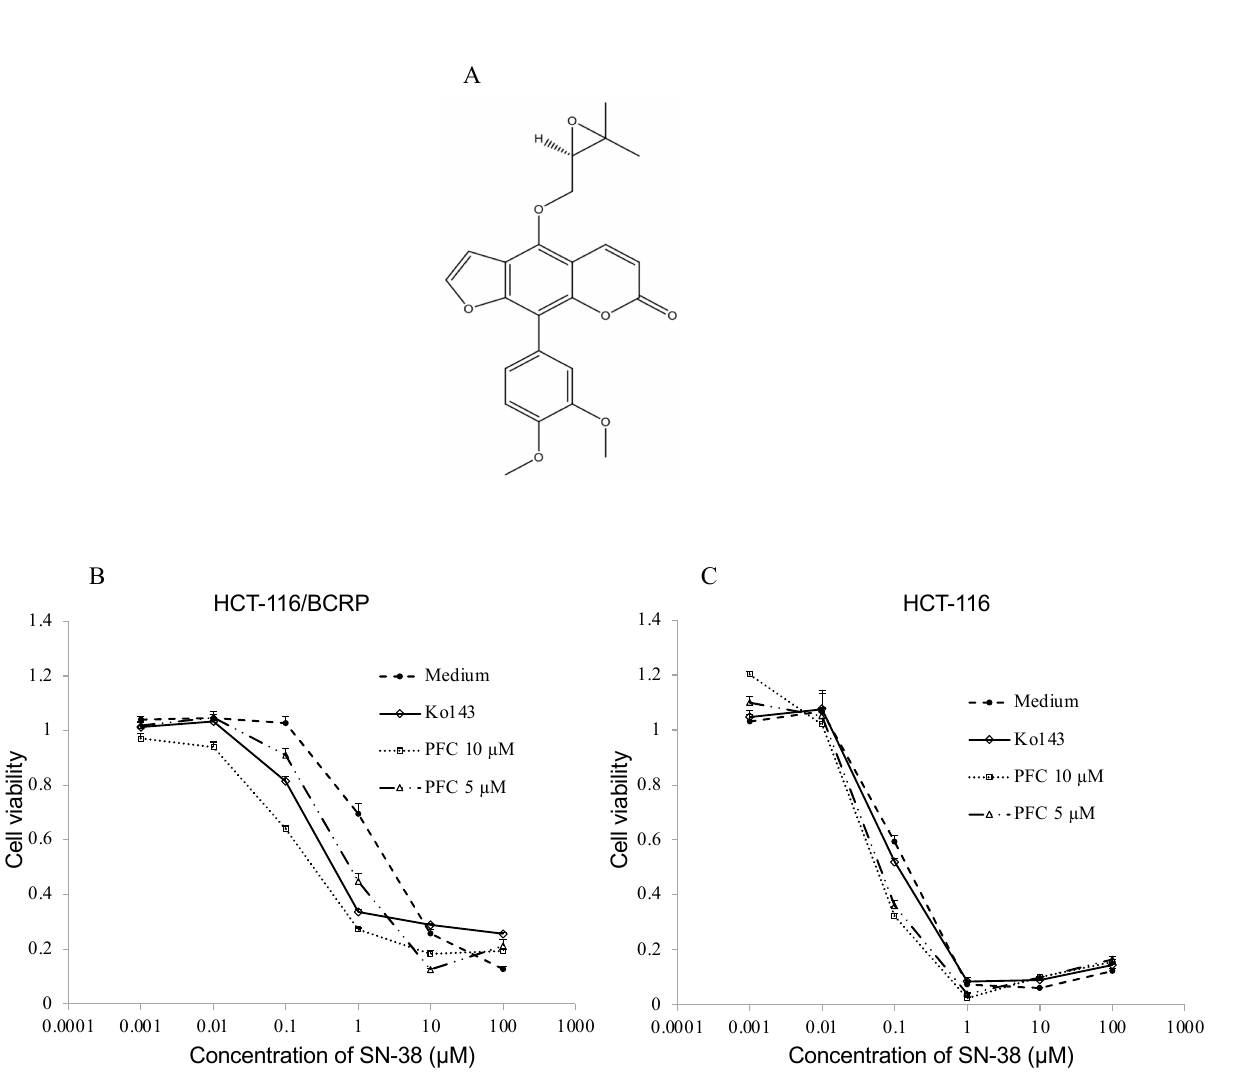
Figure 2. ( A ) Structure of a phenylfurocoumarin derivative (PFC). ( B , C ) Effect of PFC on SN-38 cytotoxicity in HCT-116/BCRP ( B ) and HCT-116 ( C ) cell lines. Cells were incubated in the presence of multiple concentrations of SN-38 with 5 or 10 µ M of PFC, or 1 µ M of Ko143, or medium only (control). Viability was determined by triplicate MTS assays. These figures show the result of one representative experiment of three independent experiments. Points, mean ( n = 5); bars, SD. Table 1. The phenylfurocoumarin derivative PFC reverses ABCG2-mediated drug resistance to SN- 38.